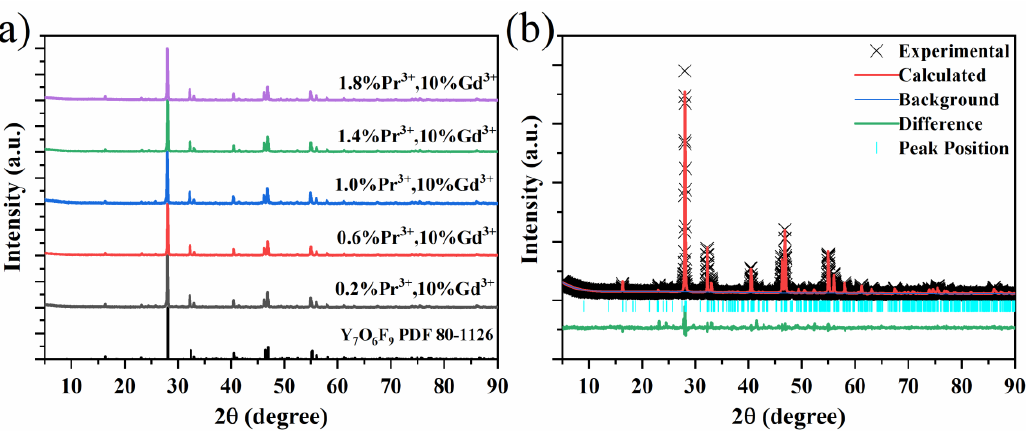
Figure 1. ( a ) XRD patterns of Y 7 O 6 F 9 :Pr 3+ , Gd 3+ phosphors. ( b ) Results of the Rietveld refinement on Y 7 O 6 F 9 :1.4%Pr 3+ , 10%Gd 3+ . Table 1. Cell parameters of Y 7 O 6 F 9 :1.4%Pr 3+ , 10%Gd 3+ obtained from the Rietveld refinement.